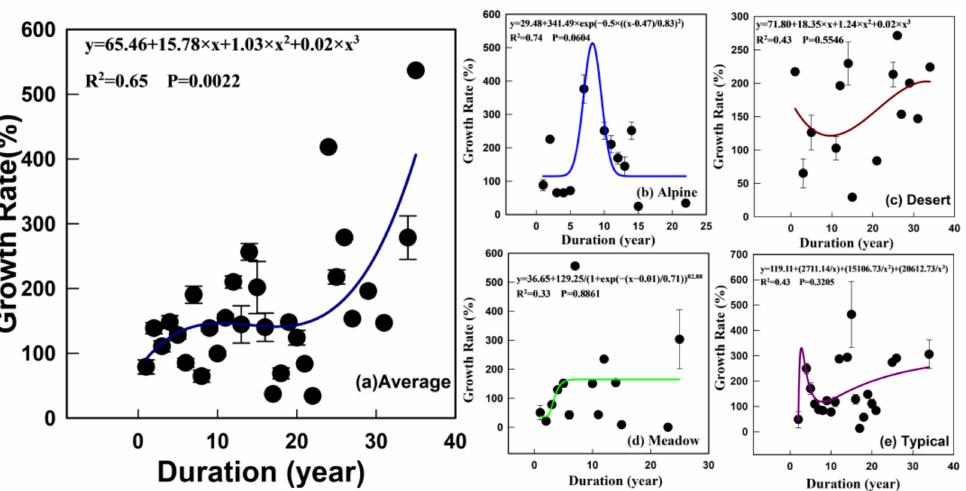
Figure 4. Average growth rate of aboveground biomass (a ) and growth rate of aboveground biomass in different grassland types ( b – e ). Error bars are 95% confidence intervals.